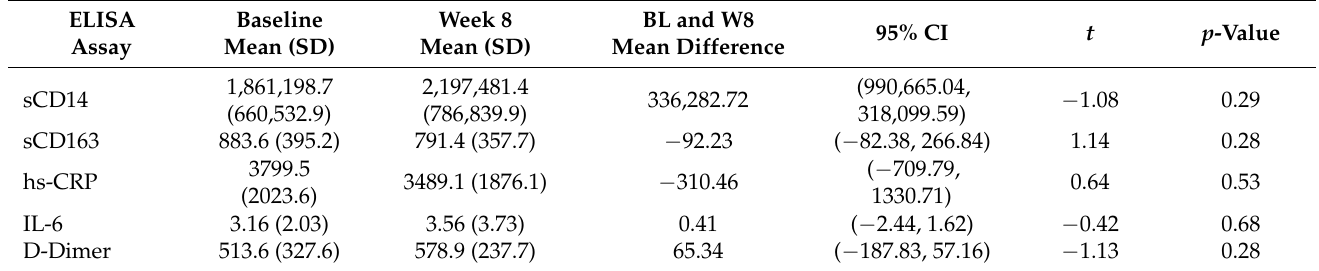
Table 2. Mean (SD) biomarker for plasma samples at baseline, week 8, and mean